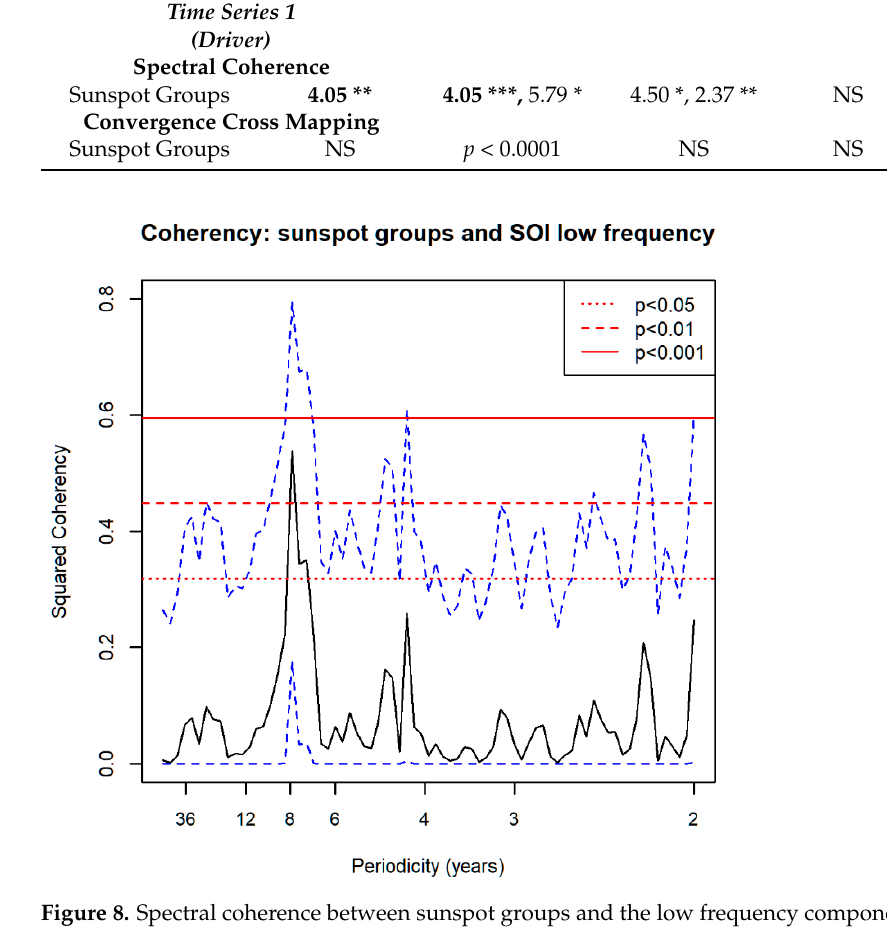
Table 2. Spectral coherence and convergent cross mapping CCM results between sunspot groups and oceanic indices. For spectral coherence significant coherent frequencies are denoted * for p < 0.05; ** for p < 0.01; *** for p < 0.001. Frequencies common to at least two pairs of time series in a row are highlighted in bold. NAO = North Atlantic Oscillation; NAOlf = low frequency component of NAO; IOD = Indian Ocean Dipole; SOI = Southern Oscillation Index; SOIlf = low frequency component of SOI. Time Series 2 (Response) NAO